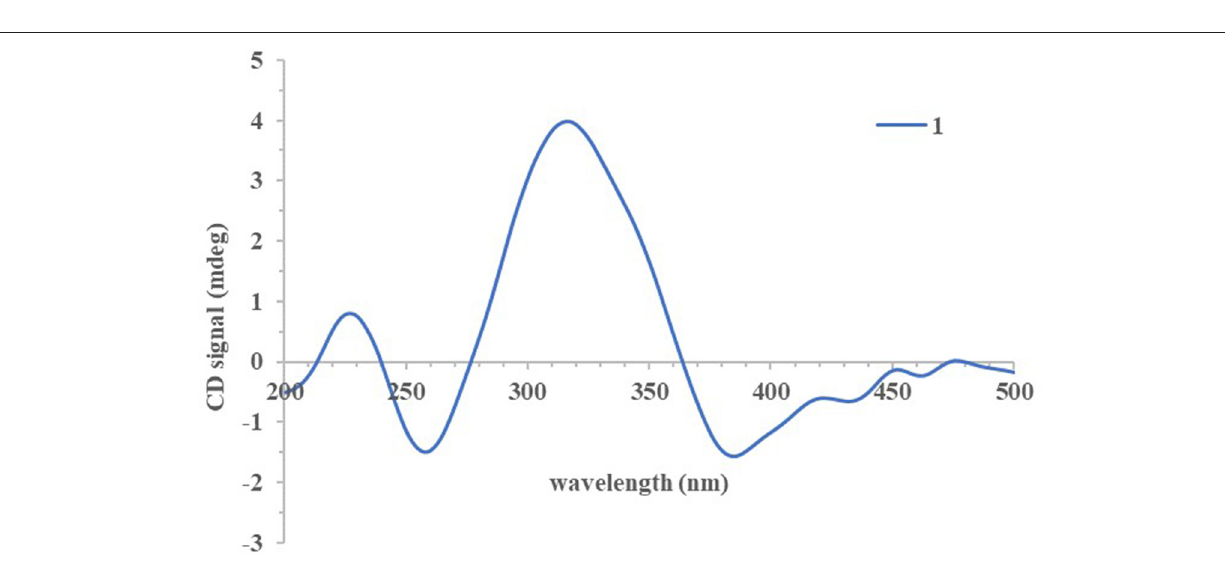
differences between 1a and isochromophilone C, indicating they were